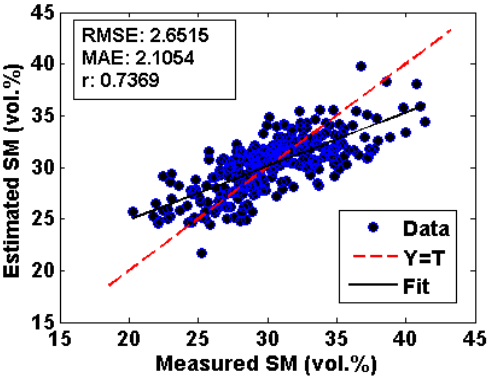
Figure 9. The relationship between measured and estimated SM for Dataset 2.